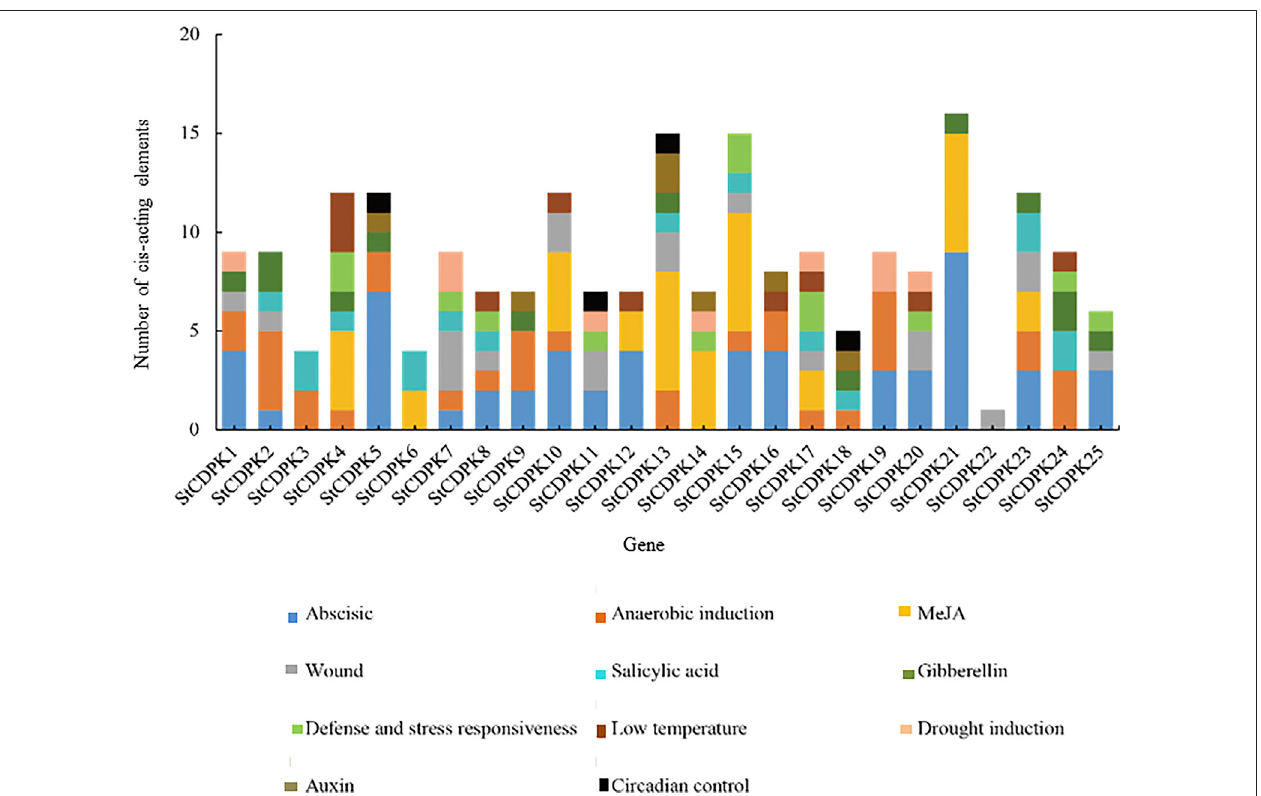
FIGURE 5 | Distribution of stress-related cis-elements in the promoters of the StCDPKs family. The elements were partitioned into different categories; biotic responsive (defense, wound), abiotic responsive (drought induction, anaerobic induction, low temperature), and phytohormones responsive (abscisic, auxin, salicylic acid, MeJA, gibberellin). These stress-related elements are indicated by different color boxes in the